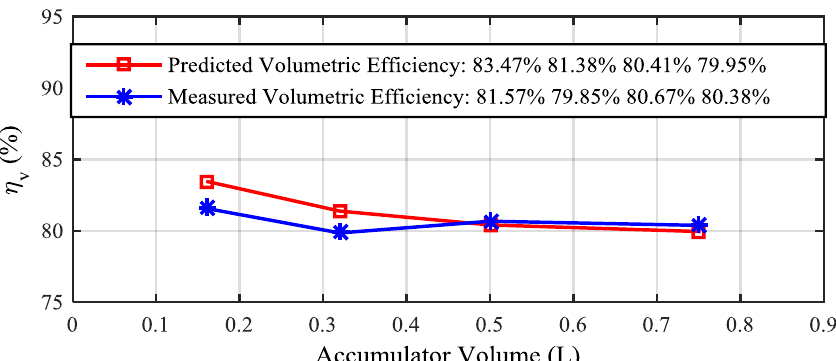
Figure 19. Hydraulic motor volumetric efficiency between predictions and measurements at 0.16 L, 0.32 L, 0.50 L and 0.75 L accumulator capacities.